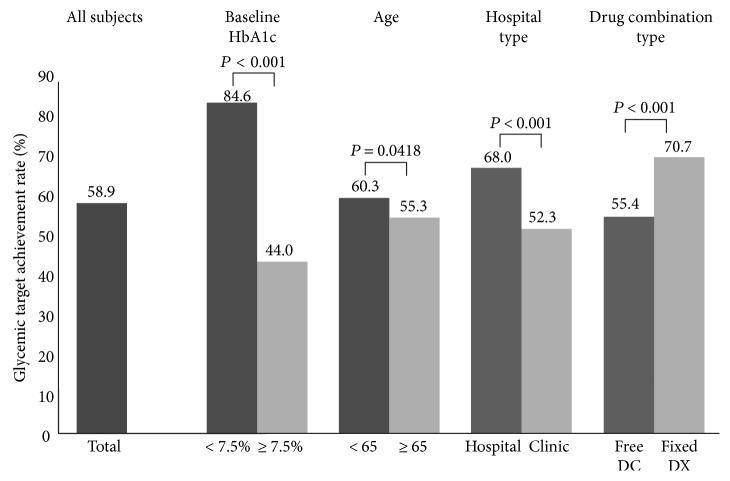
Proportion of patients achieving the glycemic target (HbA1c ≤ 7.0%) at 24 weeks. Free DC: free drug combination; Vilda/Met FDC: vildagliptin + metformin fixed dose combination.